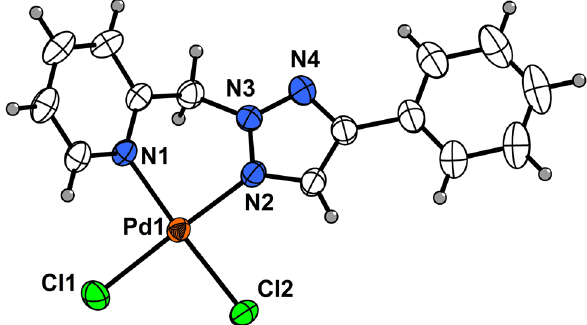
Table  : Data collection and